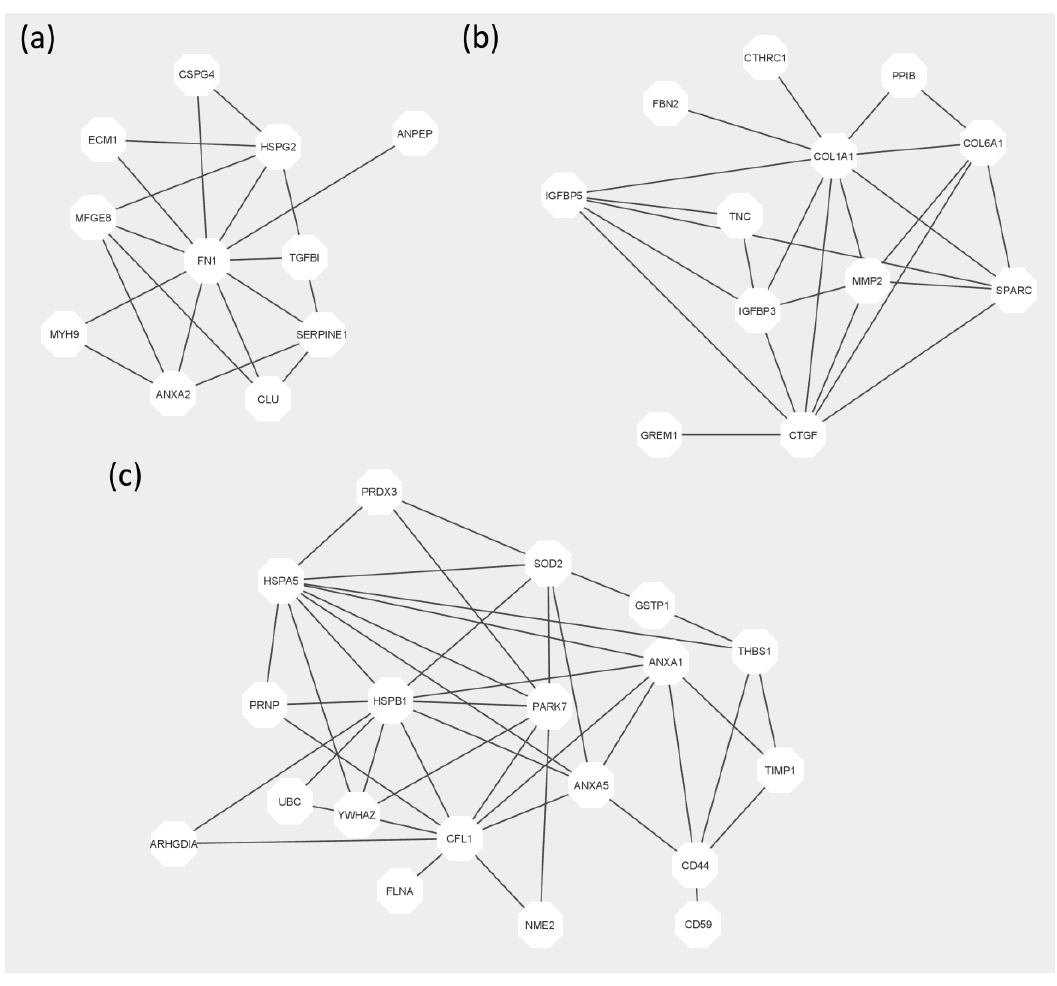
Figure 3. Interaction networks of proteins identified in the FetMSCs secretome involved in ( a ) angiogenesis, ( b ) osteogenesis and ( c ) negative regulation of apoptosis based on STRING database.